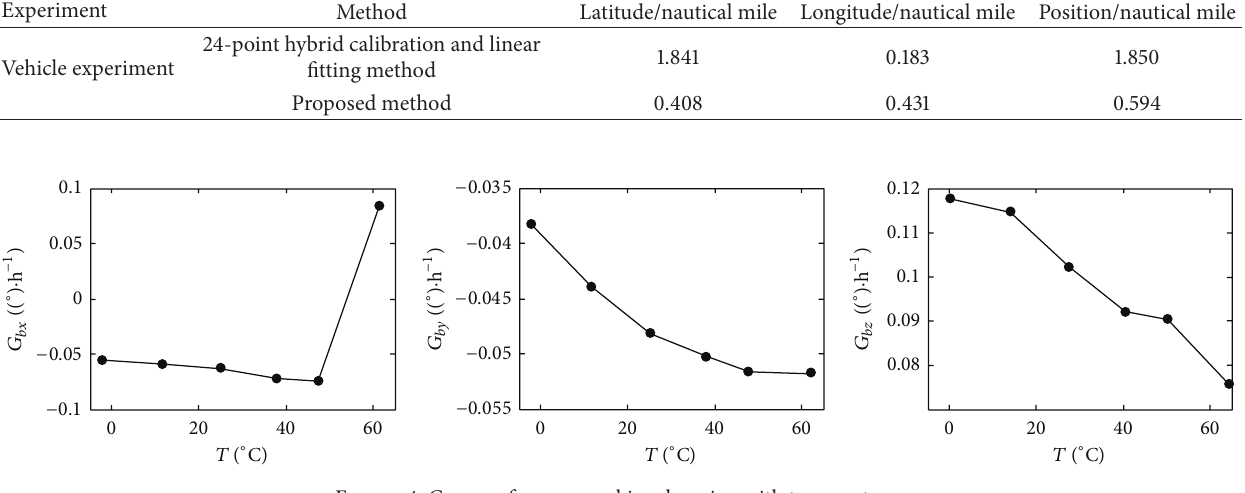
Figure 4: Curves of gyroscope bias changing with